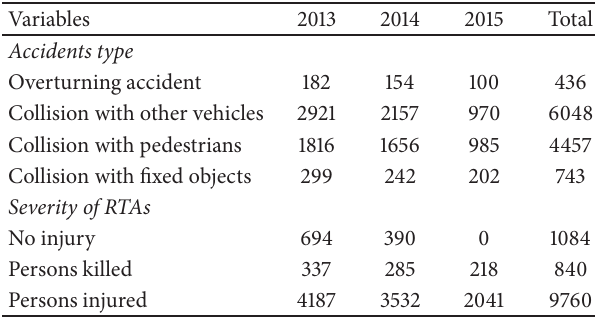
Table 1: Road vehicle accidents type and persons killed and injured ( 𝑁 = 11684 ).